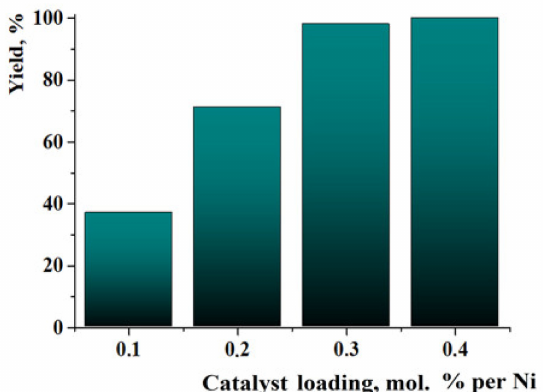
Figure 10. Yields of 1,2,3,4-tetrahydroquinoline in experiments on the hydrogenation of quinoline in the presence of very low catalyst loadings. Reaction conditions: T = 100 ◦ C, p(H 2 ) = 100 atm, 72 h,